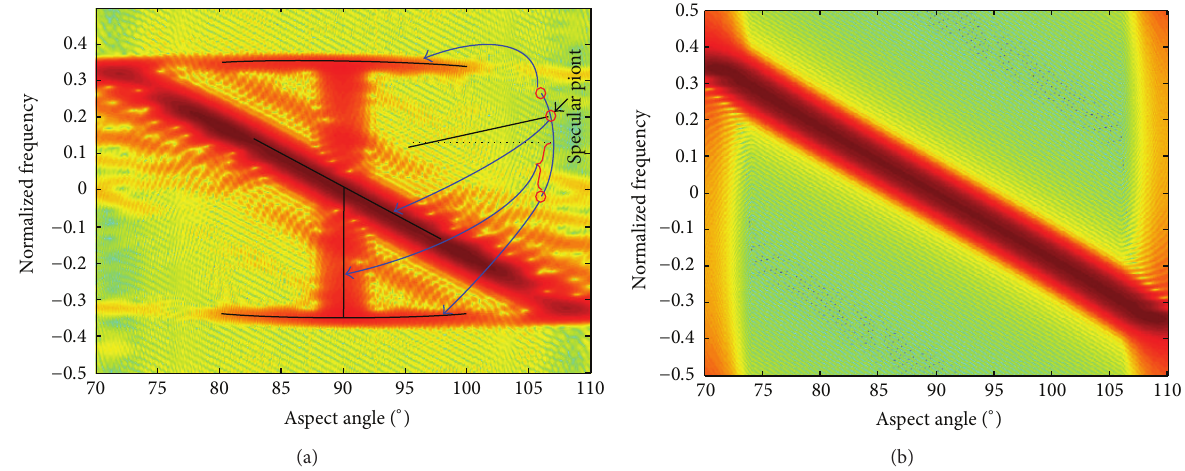
Figure 7: TFD of the PRA with data from (a) GRECO and (b) our PRA scattering center